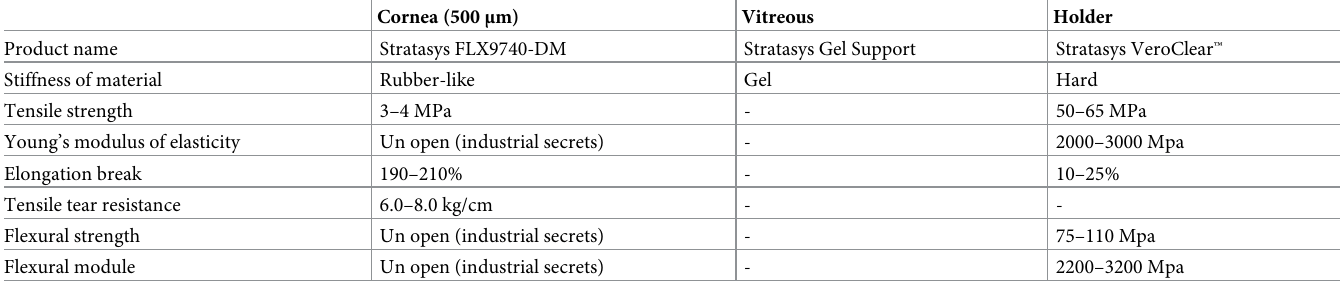
Table 1. Material parameters of the eye